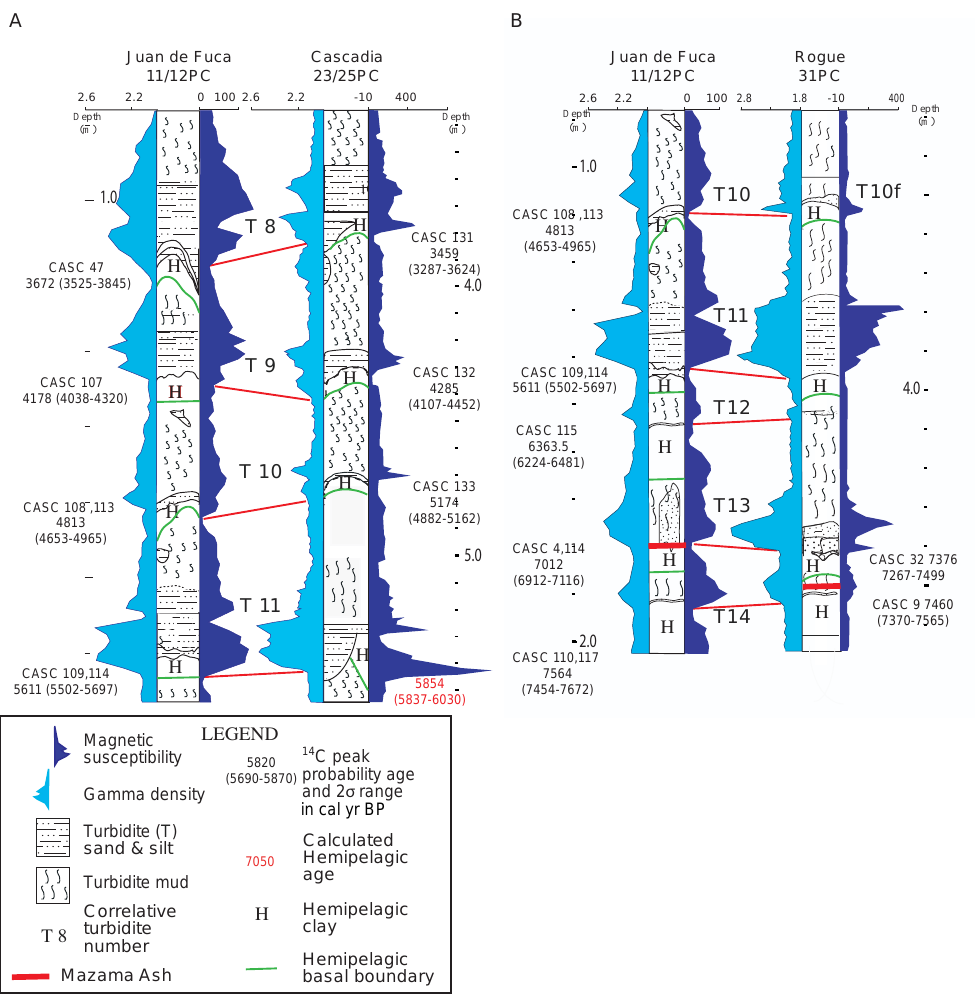
Fig. 5. An example of correlation between three piston cores: 12PC in Juan de Fuca Channel, 23PC in Cascadia Channel and 30PC in Rogue Apron. In the drawing, 14 CcalyrBP ages are shown in black. Hemipelagic thicknesses are shown in the drawing with a capital H at the base of the measured thickness. Correlation of turbidites is based on number of post-Mazama turbidites, radiocarbon ages, and magnetic and density log signatures. Note the similar physical property and thickness characteristics for each correlative turbidite (e.g. T 11) found in three different turbidite system types (Juan de Fuca, Cascadia and Rogue) for 600km along the Cascadia margin. (Figure is modified from Guti ´ errez Pastor et al.,